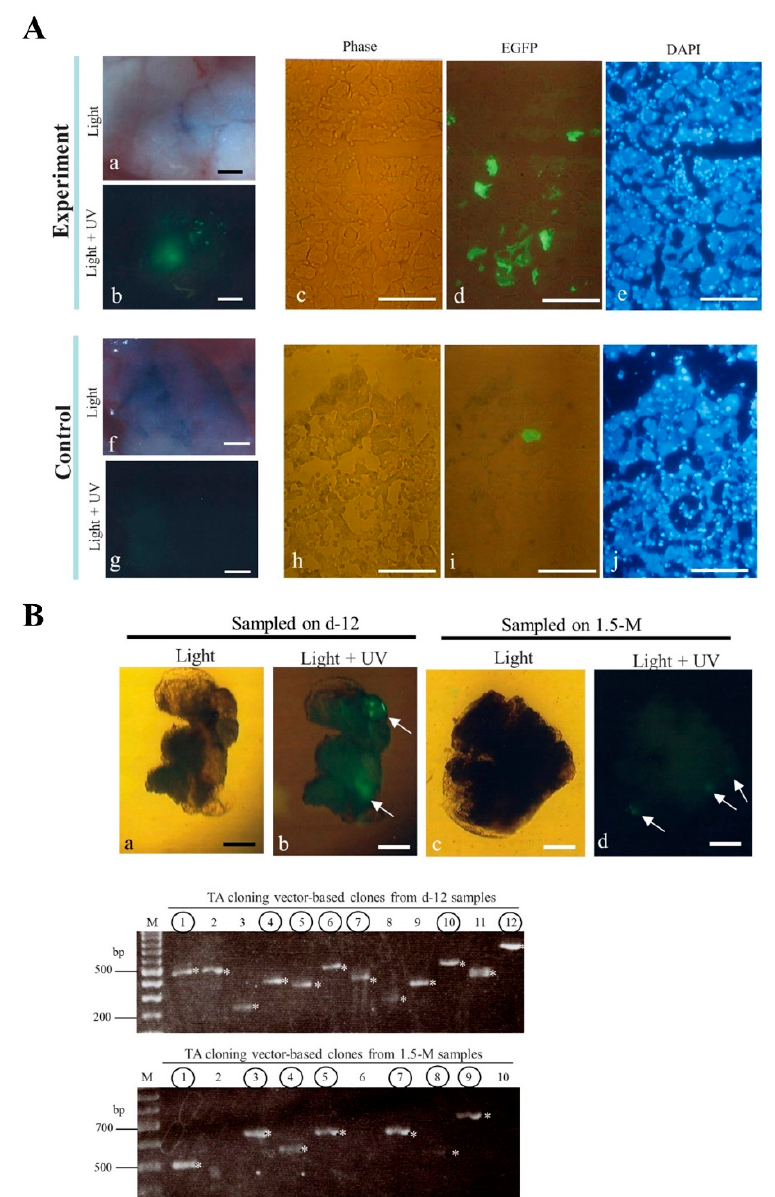
Figure 3. Inspection of the EGFP-derived fluorescence in the pancreas 1.5 months after IPPIGT (upper panels) and Splinkerette-PCR analysis (lower panels). ( A ) Adult pancreas 1.5 months after IPPIGT with pTrans + pT-EGFP (Experiment) or pT-EGFP alone (Control). The injected portion (which can be visualized by the presence of TB and expression of green fluorescence shown in a,b and f,g) was then subjected to cryostat sectioning. The sections were inspected for EGFP fluorescence after counterstaining with DAPI (c–e for experimental group and h–j for control group). Light, photographs taken under light; Light + UV, photographs taken under light + UV. Bar = 100 µ m. ( B ) Dissection of pancreas 12 days (12-d) or 1.5 months (1.5-M) after IPPIGT with pTrans + pT-EGFP (upper panels) and 2% gel electrophoresis of Splinkerette-PCR products (lower panels). A portion of pancreas showing EGFP-derived fluorescence (shown by arrows in a–d) was dissected under inspection using a fluorescence dissecting microscope. Genomic DNA isolated from the dissected pancreatic tissues was next subjected to Splinkerette-PCR as described in the materials and methods section. The resulting Splinkerette-PCR products were then cloned into TA cloning vectors. PCR was performed on the resulting TA clones as a template using universal primers, and the products were analyzed in 2% agarose gels (lower panel). Light, photographs taken under light; Light + UV, photographs taken under light + UV. Bar = 100 µ m.